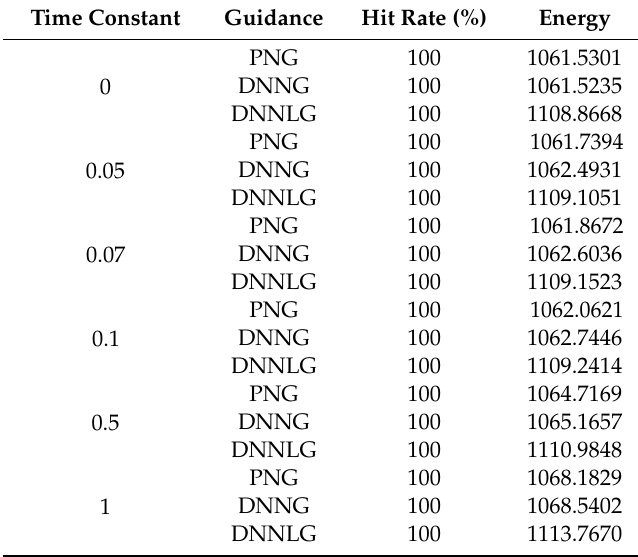
Table 5. Hit rate and average energy of the three different guidance laws for 150 random initial conditions according to time